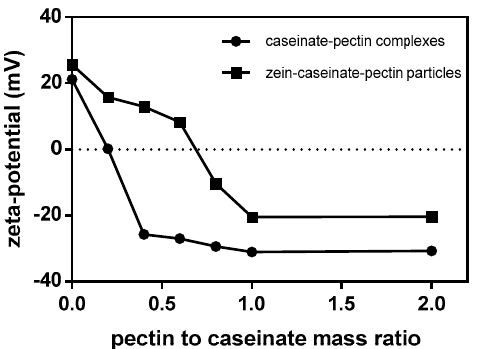
Figure 1. ζ‐ potential as a function of pectin to caseinate mass ratio of caseinate ‐ pectin complexes ( ● ) and zein ‐ caseinate ‐ pectin particles ( ■ ).